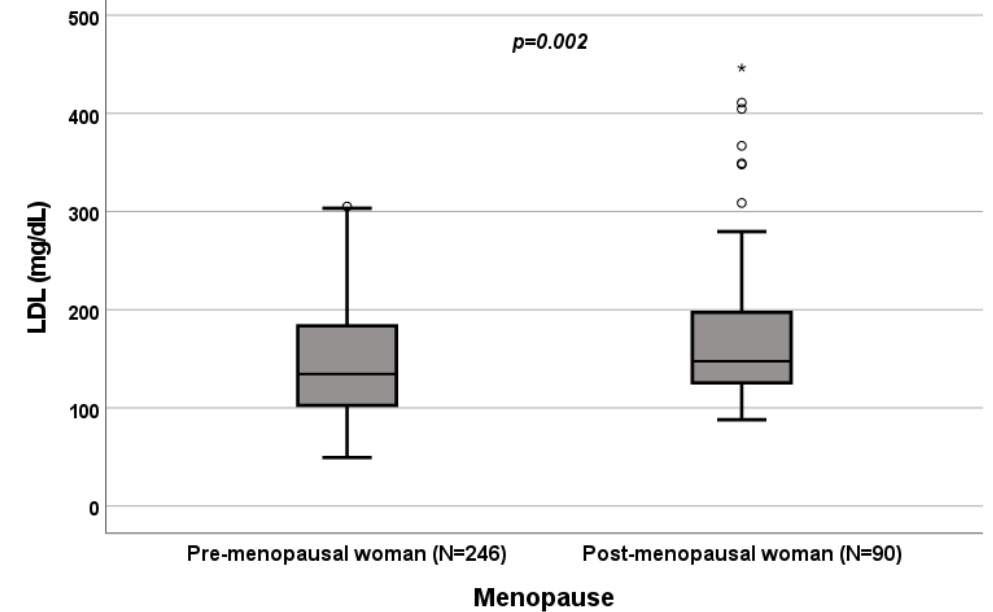
Figure 6. Influence of sex on LDL levels (mg/dL). Box plot of sex’s influence on LDL levels (mg/dL): The black lines in the boxes show the interquartile ranges (IQRs): quartile 1, median values and quartile 3; the open dots and stars describe the outlier values. The p -value is shown.